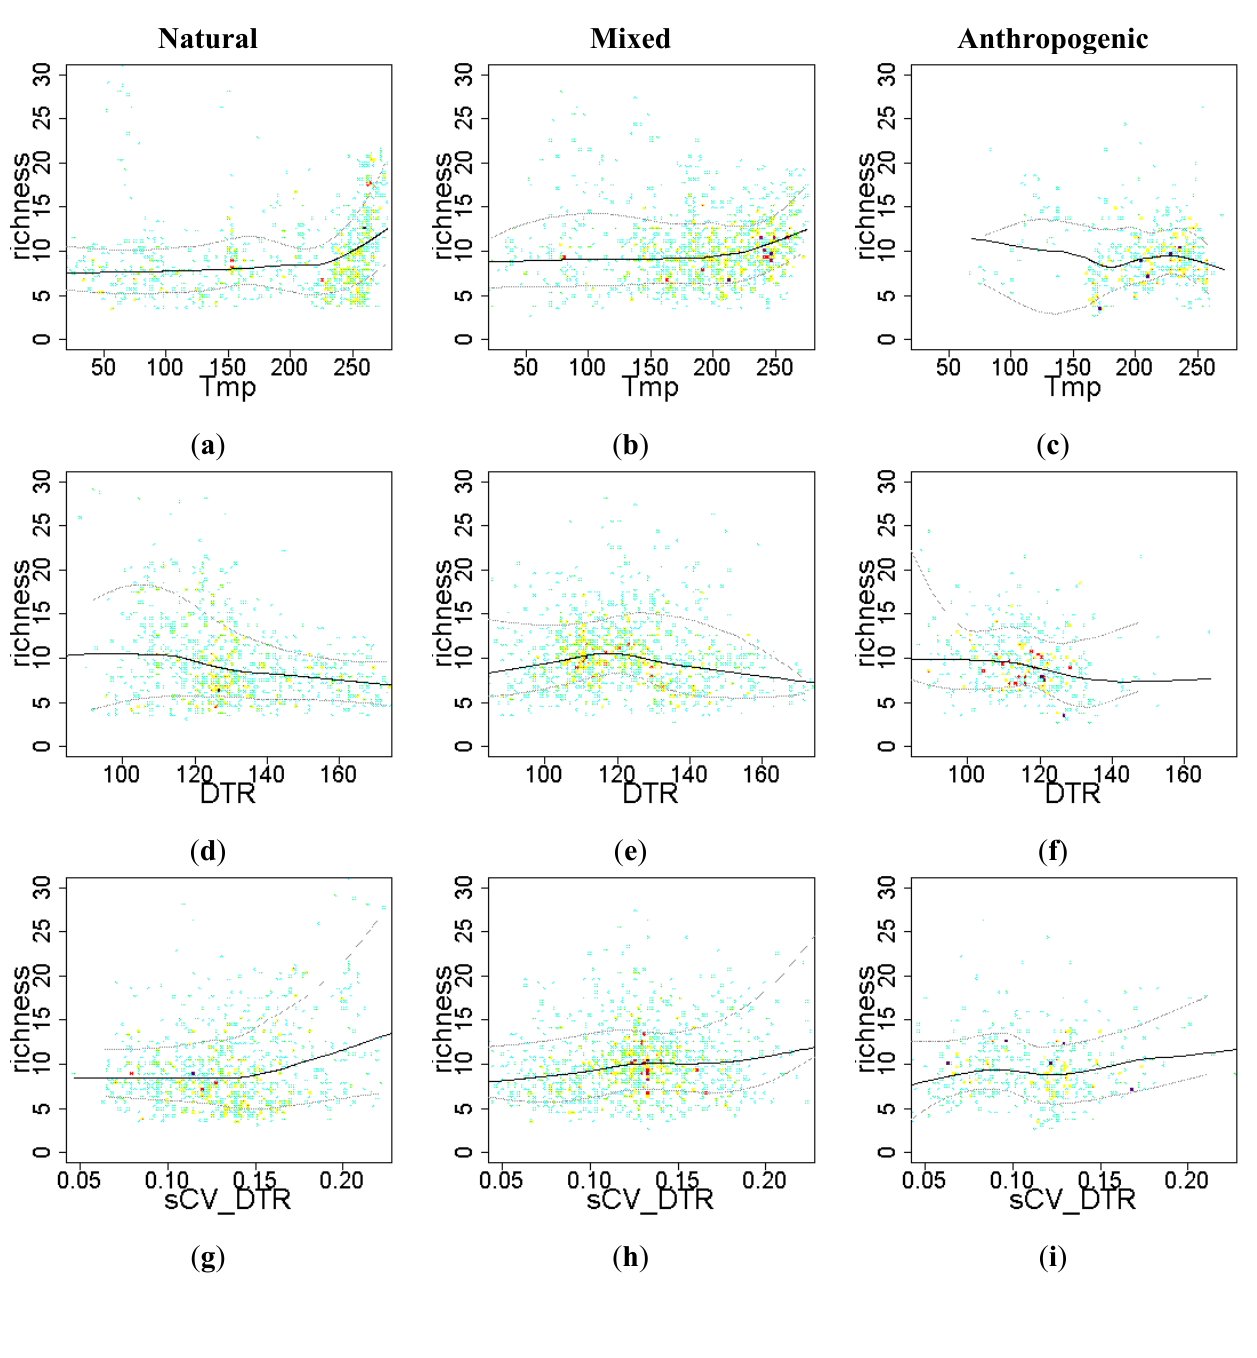
Figure 7. Relationship between the EFT richness and “energy” and “relief” variables. To visualize the sense of the effect, we used warmer colors for high point density and Local Polynomial Regression Fitting (LOESS) on the 10th, 50th and 90th percentiles. Relationships were compared across a Human Influence Index (HII) gradient: natural (HII < 10), mixed (10 < HII < 20) and anthropogenic systems (HII > 20). Tmp: temperature; DTR: diurnal temperature range; sCV_DTR: seasonal coefficient of variation of